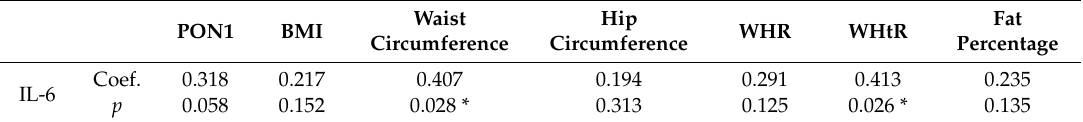
Table 4. Correlations of Interleukin 6 (IL-6) with anthropometric variables and paraoxonase 1